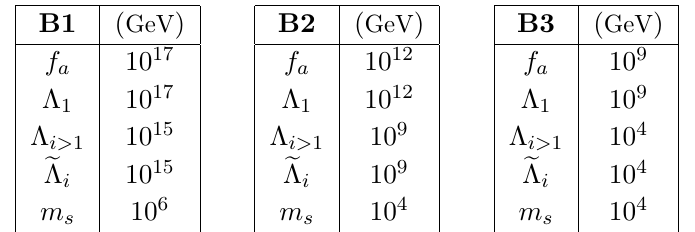
Table 3 . Three benchmark points in the parameter space of (cid:3) i and and